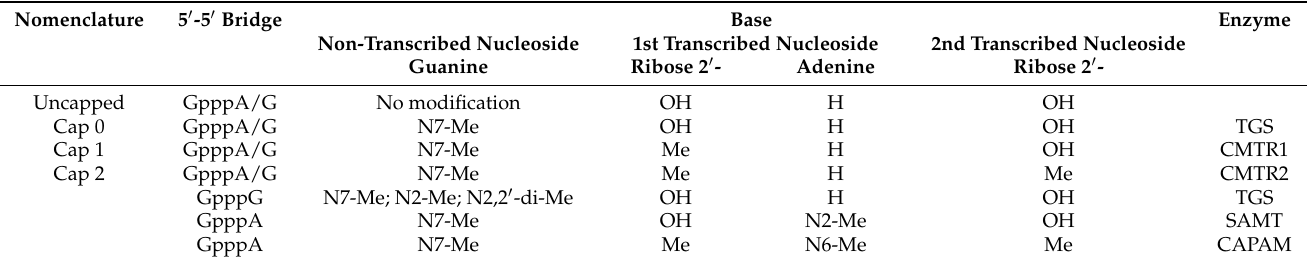
Figure 2. Chemical structure of ribonucleosides for LNP. ( A ) Structure of 5 ′ -capping (m7Gppp-A/G). R = A/G. ( B ) Uridine and a series of its analog. ( C ) 2 ′ -O-methylation and 3 ′ /5 ′ -O-phosphorothioation. R = A/G/U/C. Table 3. 5 ′ -Capping of mRNA [14].